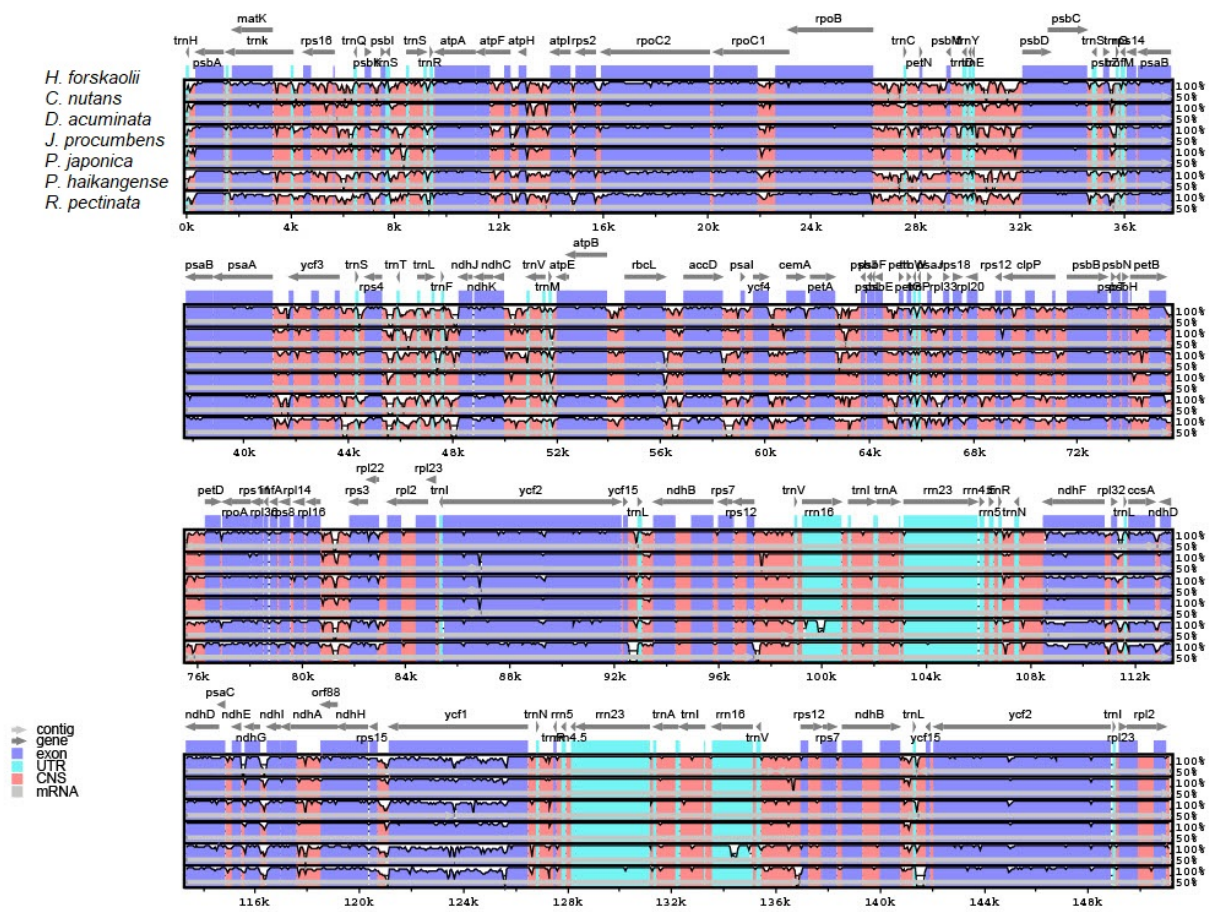
Figure 5. Variable regions in the cp genome of seven Justiceae species. The top arrow represents the direction of transcription; the colors blue and pink denote protein coding and conserved non-coding sequence, respectively; light green denotes tRNAs and rRNAs. The cp genome coordinates are shown by the x -axis, and the percentage identity ranges from 50% to 100% on the y -axis.